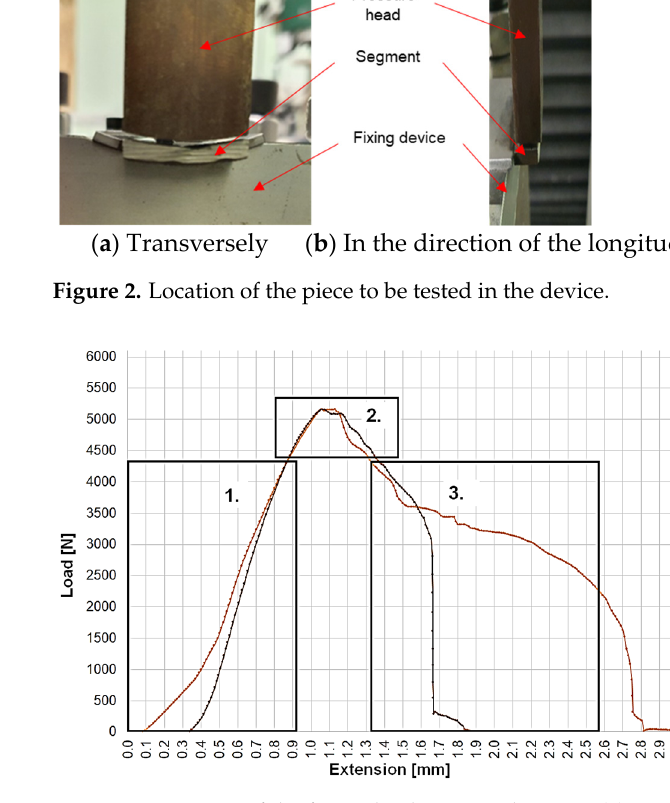
Figure 3. Structure of the force–displacement diagram. (1) Section of elastic deformation; (2) section